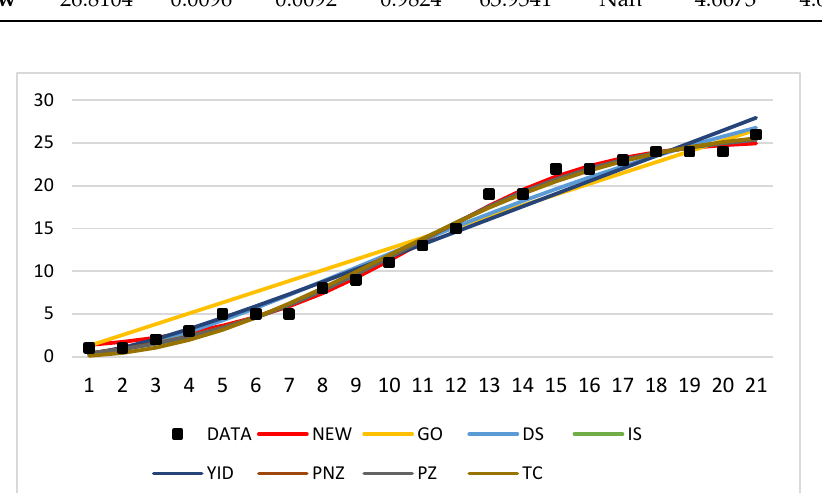
Figure 4. Mean value functions, m(t), of all models for dataset 2. Tables 6 and 7 and Figures 5 and 6 show the predicted values at t i for each dataset. The predicted values mean the expected cumulative number of failures by the proposed model. In Table 6, the predicted values for future points are {25.1102, 25.19946, 25.2552, 25.28936} at t = {22, 23, 24, 25} . In Table 7, the predicted values for future points are {194.766, 194.766, 194.766} at t = {18, 19, 20} . Table 6. Predicted values by proposed model for dataset 1. Time